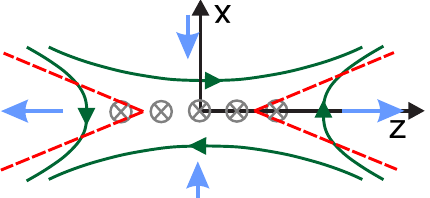
Figure 1. The current sheet of the diffusion region is represented by the circles with a cross. The plasma is reconnected at the X point and is accelerated outward along the z direction. Shock pairs can appear (dashed lines) for Petschek reconnection. Long arrows in- dicate magnetic field lines and short arrows the plasma inflow and outflow.